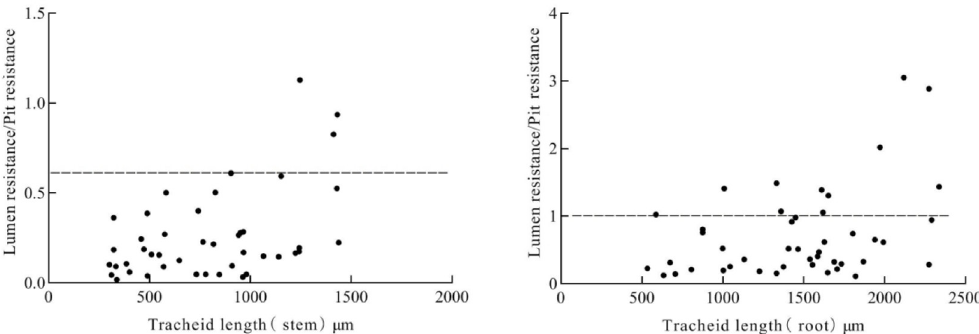
Fig 12. Scatter plot of the ratio of the tracheid lumen resistance to pit